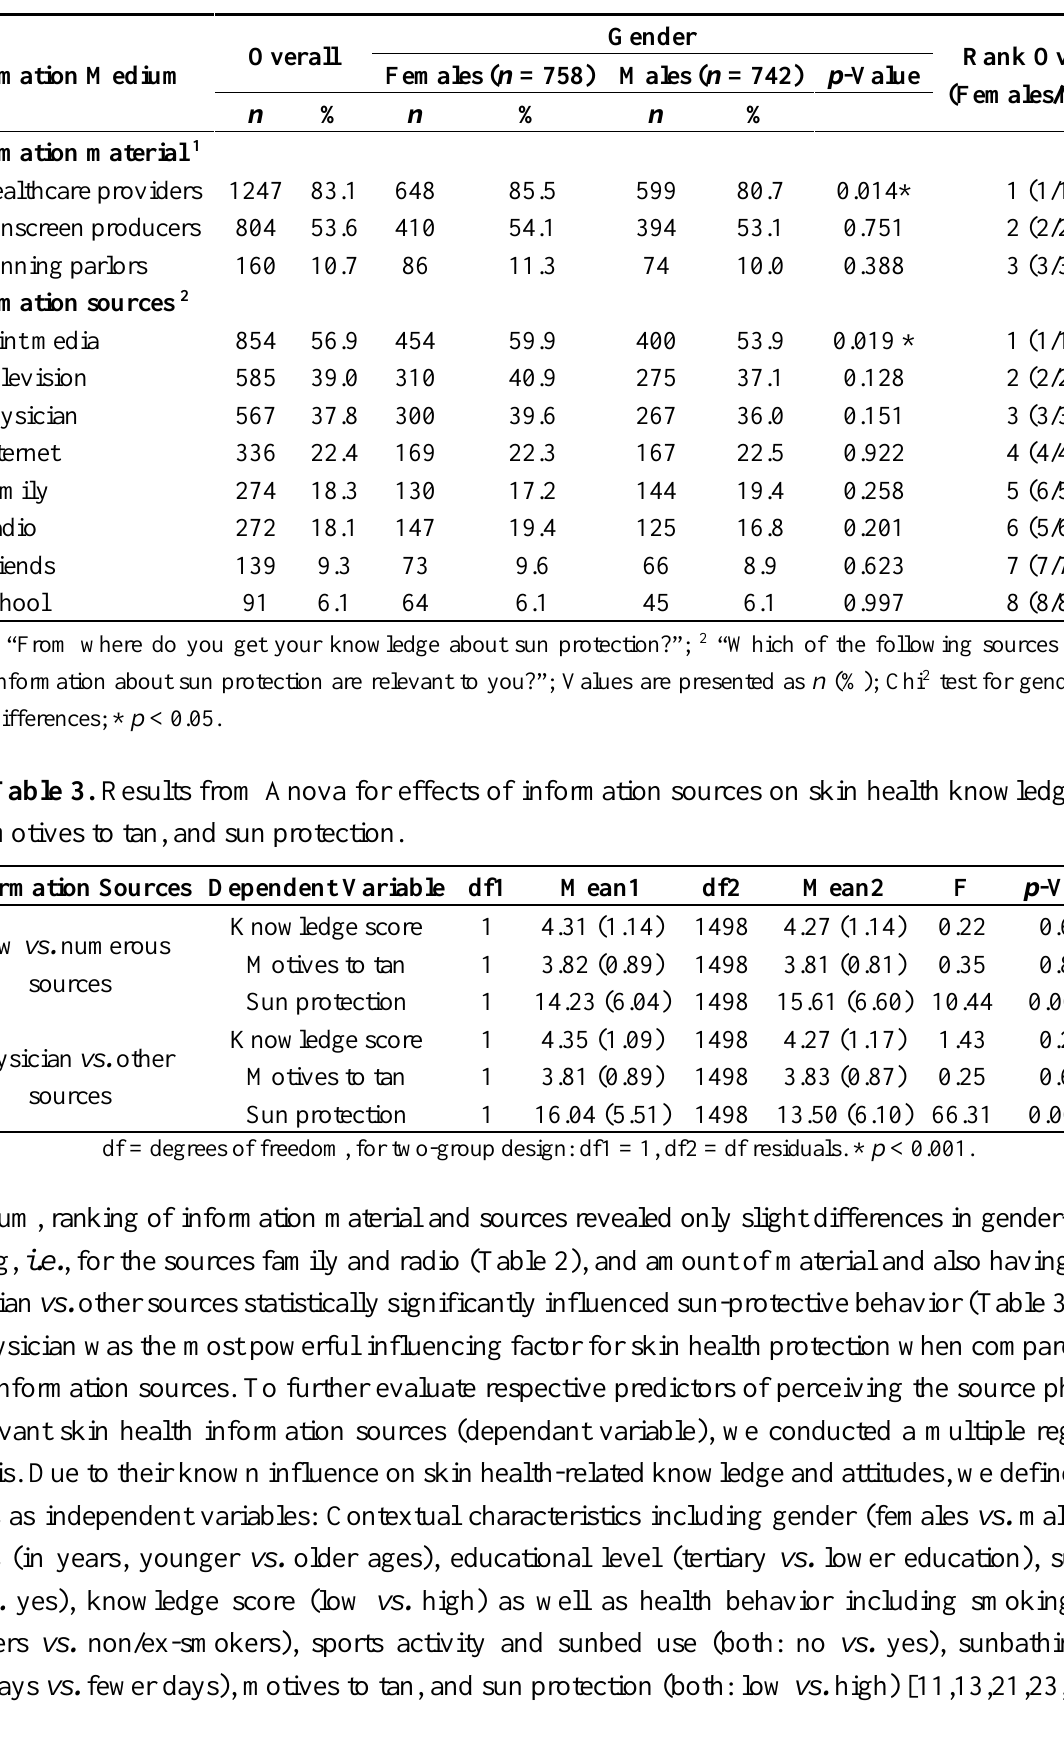
Table 2. Amount of picked skin health information material and sources, stratified by gender and ordered by total rank.